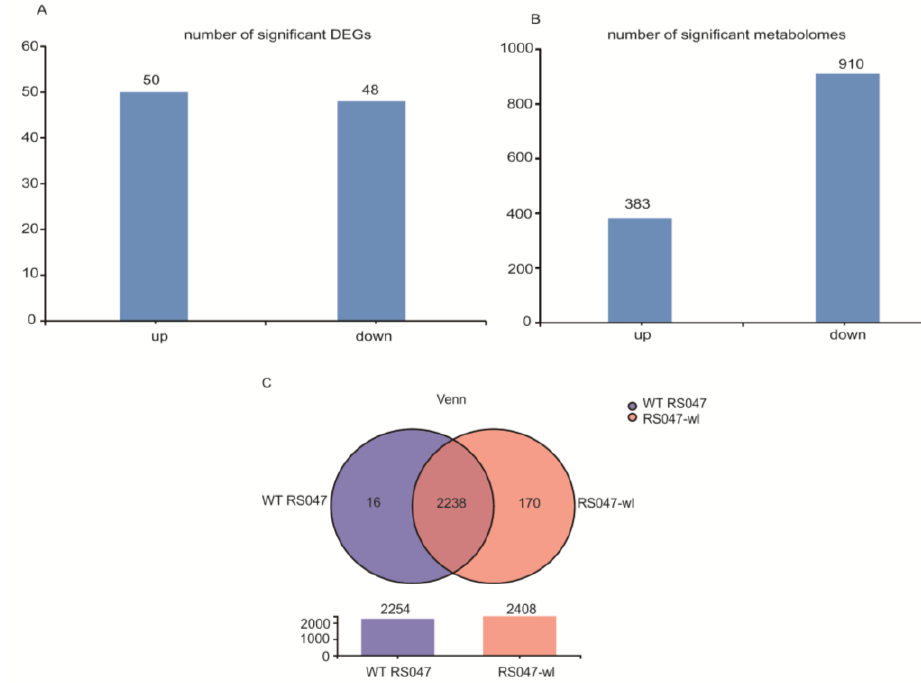
Figure 4. DEGs and differential metabolites obtained by transcriptome and metabolome analysis. The total number change of DEGs ( A ) and differential metabolites ( B ) between WT RS047 and RS047-wl. For transcriptome, a Venn Diagram indicated that 2238 genes were expressed at WT RS047 and RS047-wl ( C ).